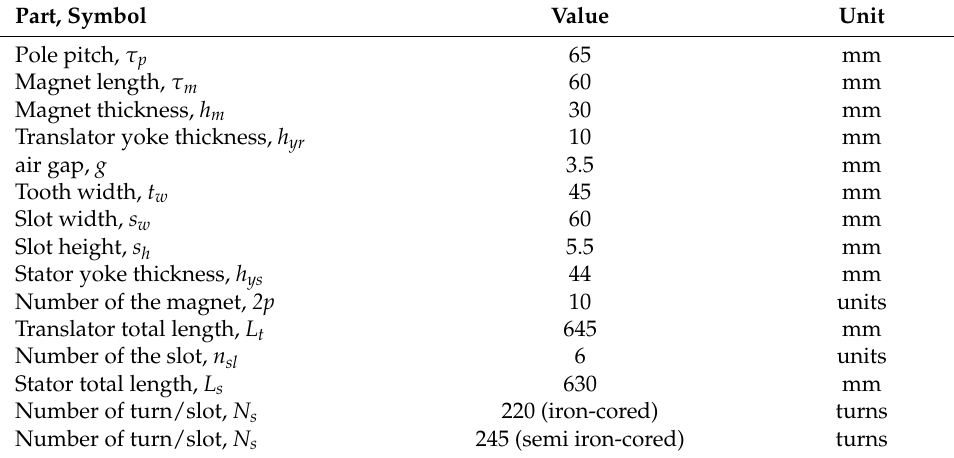
Figure 4. Illustration of the two LPMG designs: ( a ) iron-cored; ( b ) semi iron-cored. Table 1. Dimension of the LPMG designs.